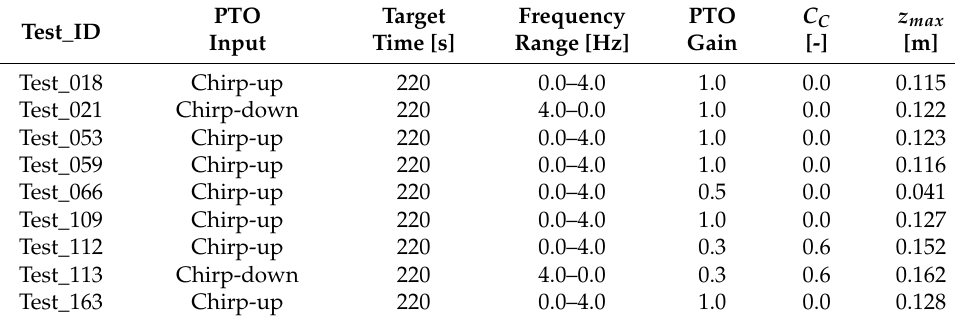
Table 4. Overview of the performed radiation tests.